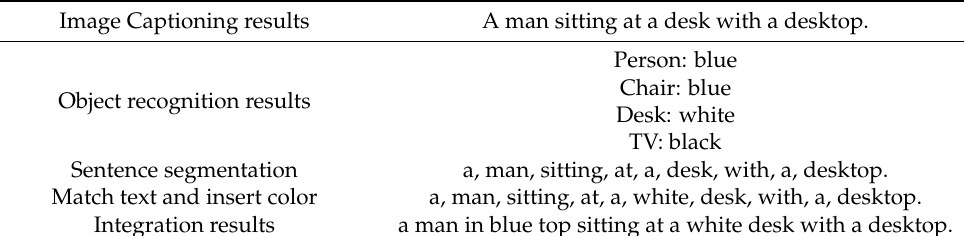
Table 3. Distribution of object size (BBox size) in open-source datasets.